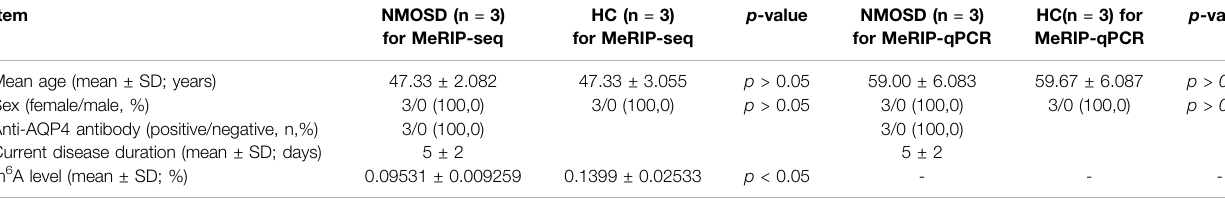
TABLE 1 | Characteristics of subjects and m 6 A levels in NMOSD patients and healthy controls. Item NMOSD (n = 3)